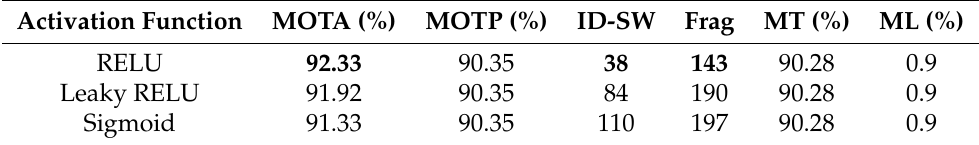
Table 5. Effectiveness of different activation functions for the proposed RelationConv